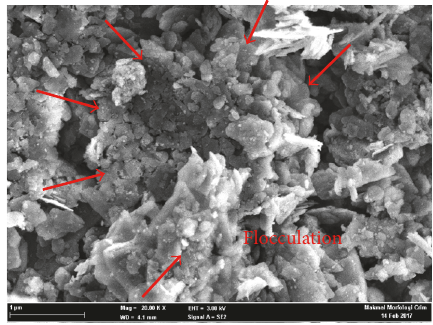
Figure 10: FESEM micrograph of soil-0.5% nanolime: Mag = 20.00 KX.